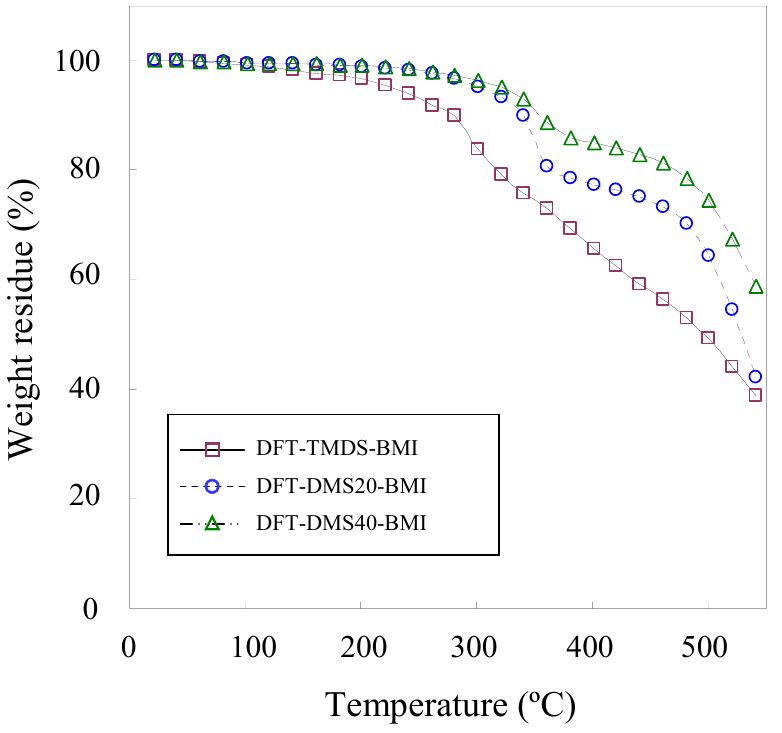
Figure 3. TGA curves of DFT-TMDS-BMI, DFT-DMS20-BMI and DFT-DMS40-BMI, measured under a nitrogen